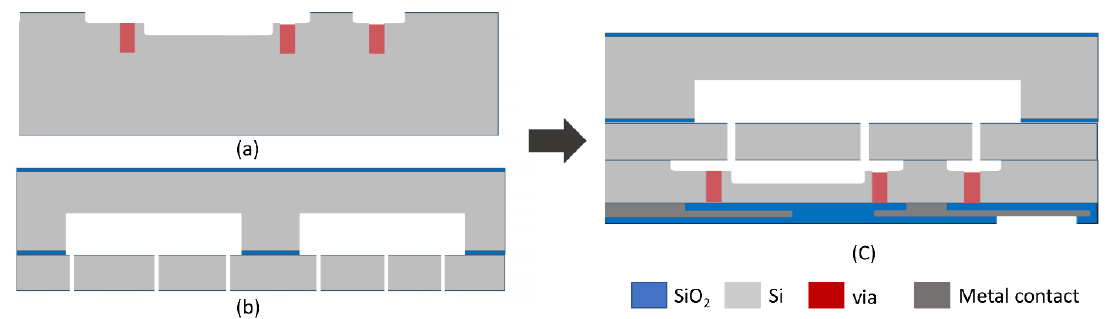
Figure 3. Cross-sectional view of the fabrication process. ( a ) Fabrication of the via wafer. ( b ) Fabrication of cap and device wafer. ( c ) Wafer level bonding and vacuum packaging.